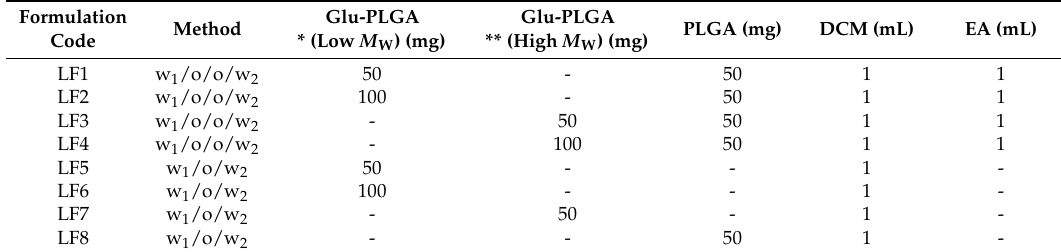
Table 1. Polymer and solvent used for the preparation of lysozyme loaded microspheres in different